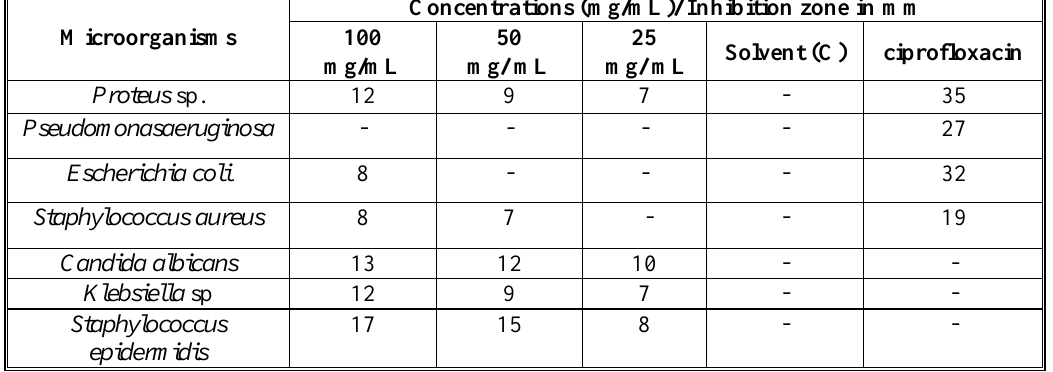
Methanol as a solvent showed no antimicrobial activity against the bacteria, while HMR lignan showed a good inhibition zone for both